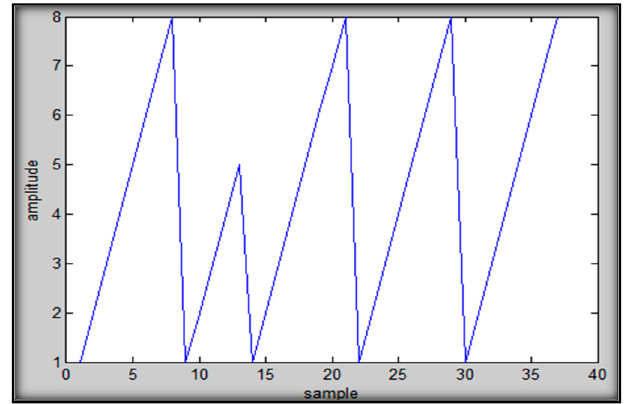
Figure 14. Data overriding.